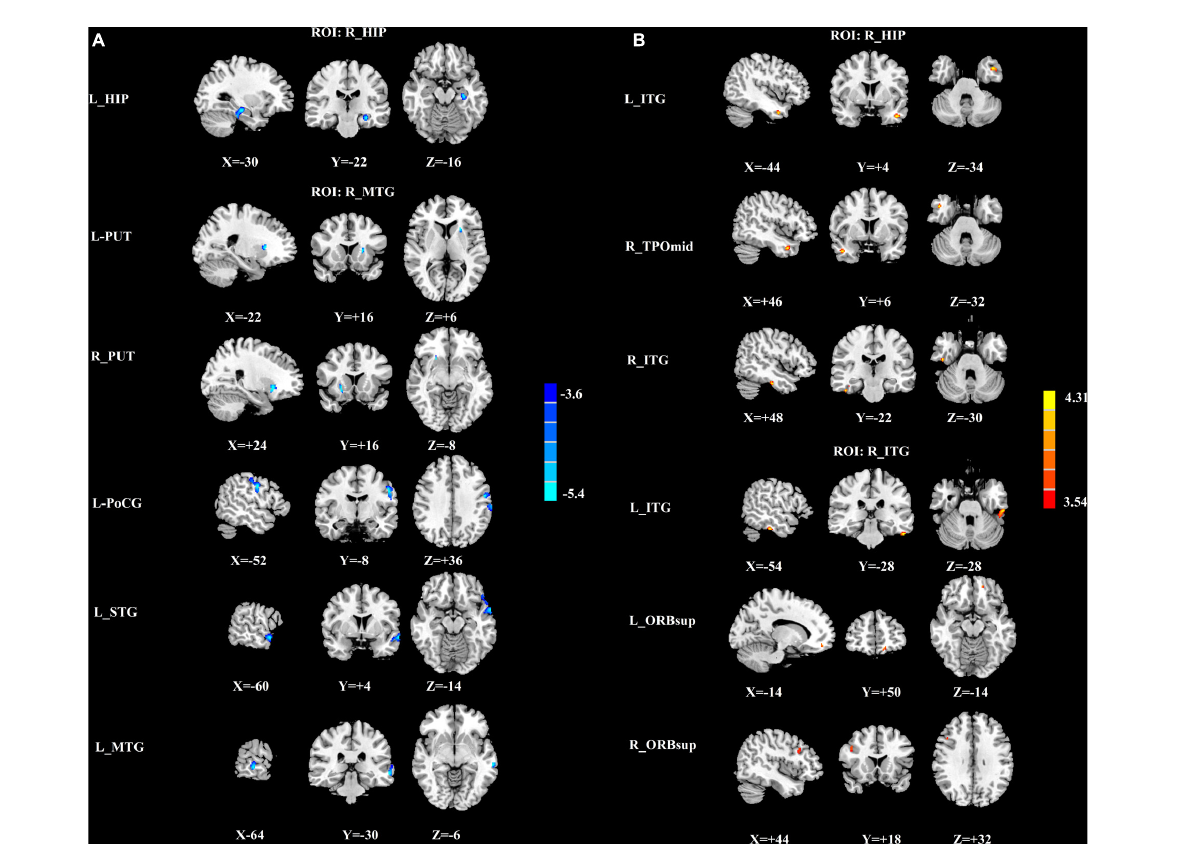
FIGURE4 (A) The significantly different brain regions of CBF connectivity between men patients and men controls based on the ROI of R_HIP and R_MTG. The cold color indicates that the CBF connectivity was significantly decreased in the men patients. CBF, cerebral blood flow; R, right; L, left; HIP, hippocampus; PUT, putamen; MTG, middle temporal gyrus; STG, superior temporal gyrus; PoCG, postcentral gyrus; (B) The significantly different brain regions of CBF connectivity between women patients and women controls based on the ROI of R_HIP and R_ITG. The warm color represents the significantly increased CBF in the women patients. CBF, cerebral blood flow; R, right; L, left; ITG, inferior temporal gyrus; TPOmid, temporal pole: middle temporal gyrus; ORBsup, superior frontal gyrus, orbital part.